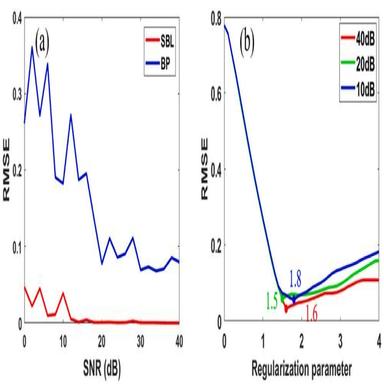
Quantitative comparison of the localization performance between SBL and BP. (a) RMSE vs SNR for SBL and BP. (b) Estimation of the optimal regularization parameters γ for the BP method.